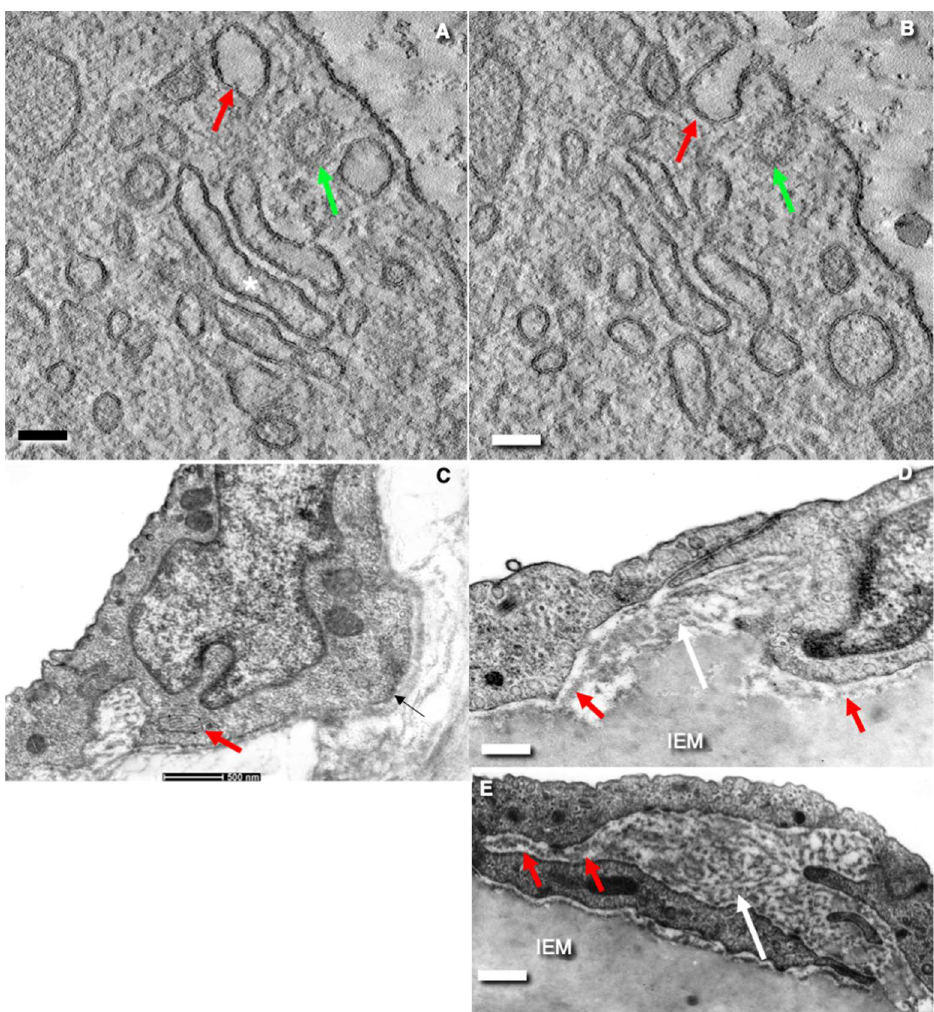
Figure 4. Structure of rat endothelial cells. ( A – D ) Serial virtual tomography slices show clathrin- independent invaginations (red arrow in ( A )) and clathrin-dependent invaginations (green arrows in B ) of the EC APM. In ( B ) these seemingly isolated vacuoles are connected with the plasma membrane. The Golgi complex (asterisk in ( A )) is composed of short cisternae. ( C ) EC from rat aorta from the zone of regenerating endothelium. EC is in the G2 phase. Red arrow shows the post-Golgi carrier filled with collagen. ( D , E ) ECs of aorta. Red arrows show mesh-like BM. White arrow indicates accumulation of the BM material which is more evident in the ECs from the zone of turbulent flow. Images ( A , B ) are taken from Supplementary Figures presented by Sesorova et al. [18]. Images ( C , D ) are taken from Figure 5 presented by Sesorova et al. [16]. The image ( E ) is taken from Figure 3C presented by Mironov et al. [6] in agreement with the CC By license. Scale bars: 85 nm ( A , B ); 200 nm ( C ); 500 nm ( C ); 305 nm ( D , E ).